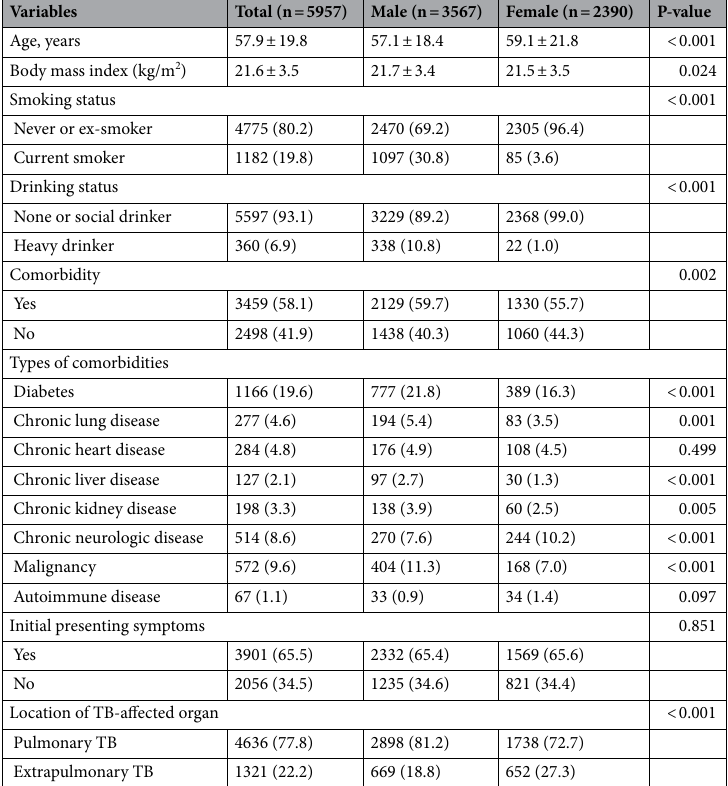
Table 1. Baseline characteristics of enrolled participants with tuberculosis stratified by sex.